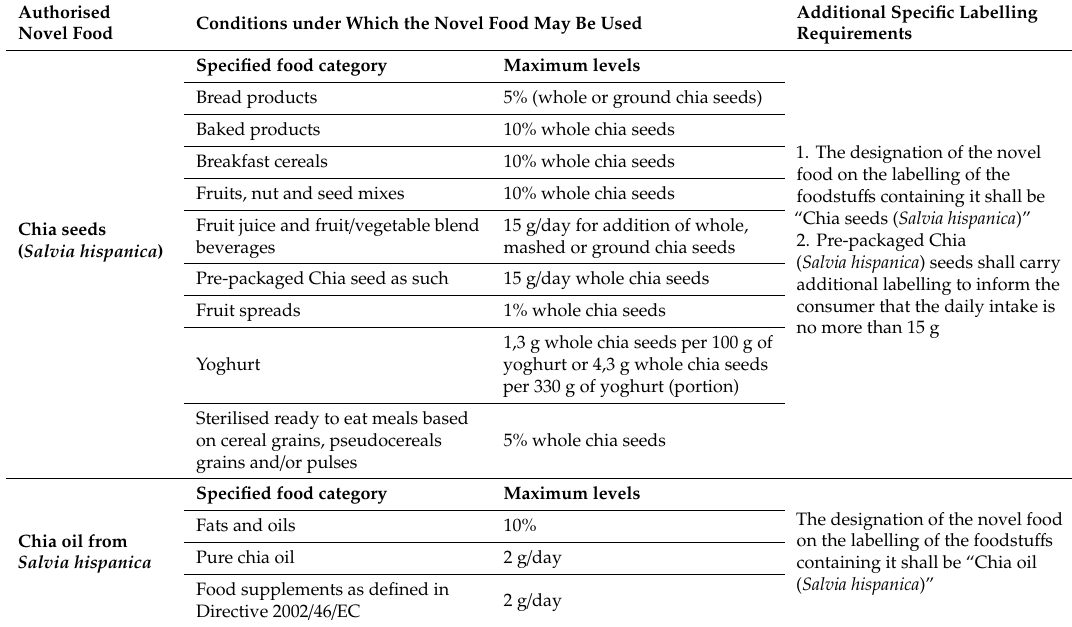
Table 5. Chia seeds and chia seeds oil as authorised novel food according to Commission Implementing Regulation (EU) 2017 / 2470 of 20 December 2017 establishing the Union list of novel foods in accordance with Regulation (EU) 2015 / 2283 of the European Parliament and of the Council on novel foods [81,82]. Authorised Novel